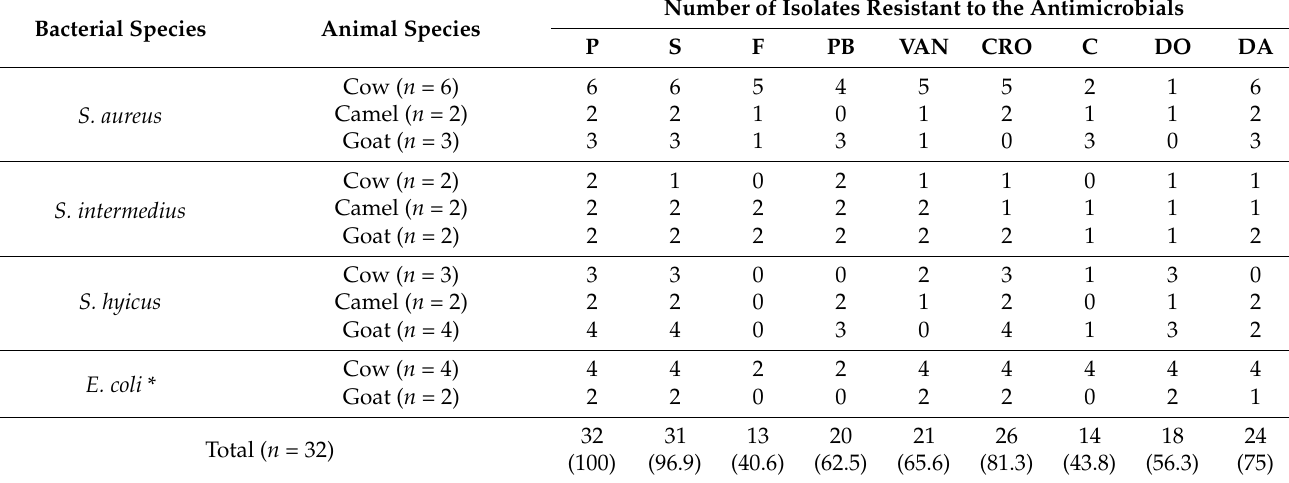
Number of Isolates Resistant to the Antimicrobials